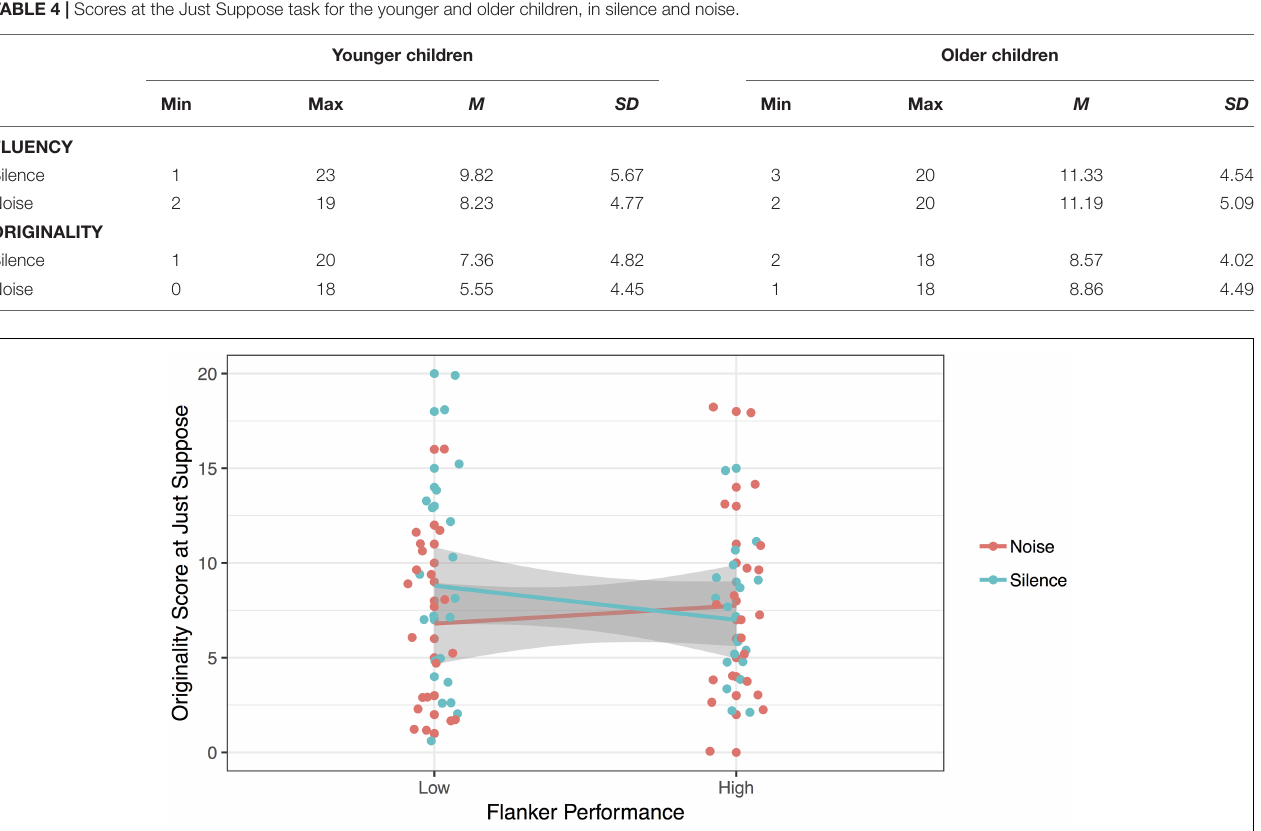
FIGURE 1 | Originality of answers at the Just Suppose task, as a function of Flanker